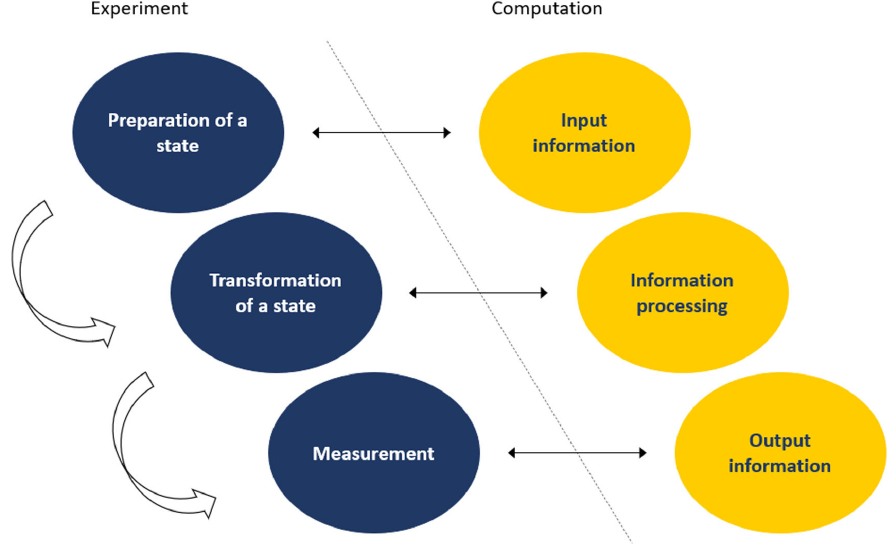
FIG. 1. The essence of the approach: the “ experiment-computation ” comparison.